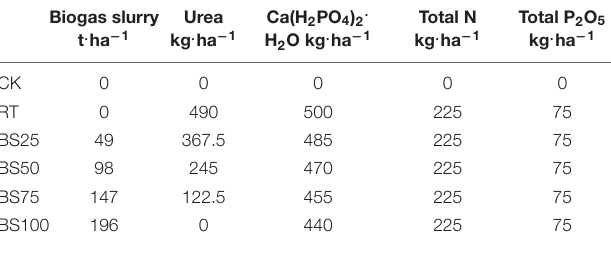
TABLE 1 | Amounts of fertilizer and biogas slurry applied in the experimental area. Biogas slurry t . ha −